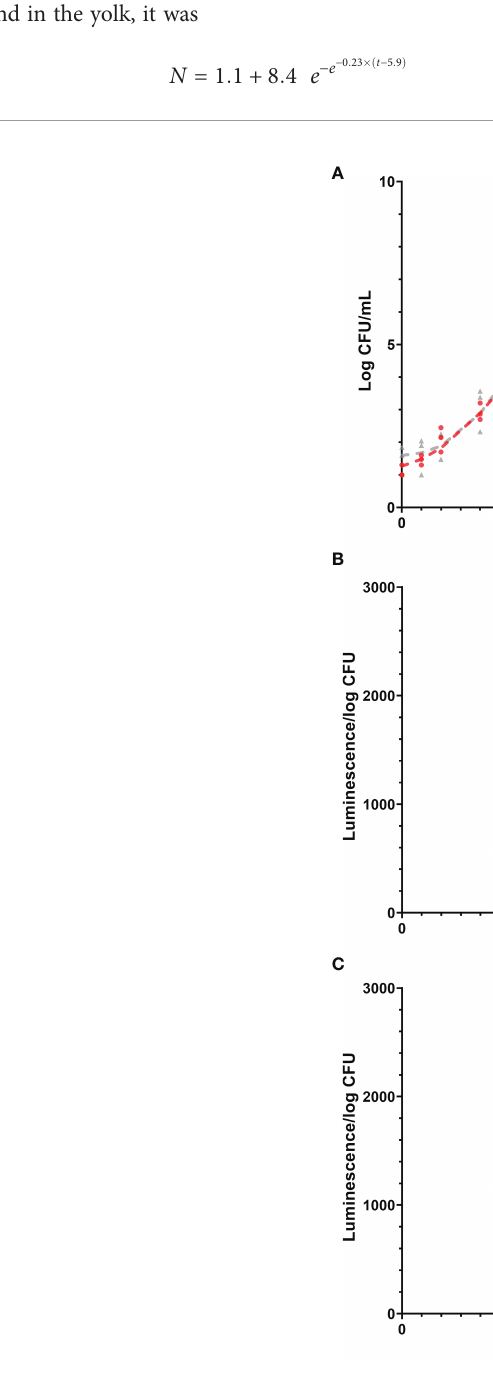
FIGURE 2 | Growth (log CFU/mL) of Salmonella Enteritidis and expression (luminescence units/log CFU) of promoters of virulence-related genes, sopB and sseA during growth of the corresponding Salmonella Enteritidis reporter strains, in tryptic soy broth (TSB) and egg yolk. Gray and red lines (and symbols) represent TSB and yolk, respectively. Log CFU/mL values are represented by symbols and growth curves, simulated by the mathematical model, are shown as dashed lines. Changes in luminescence/log CFU are represented by solid lines. (A) Growth curves of Salmonella Enteritidis in egg yolk and in TSB. (B) Expression of sopB . (C) Expression of sseA . Each error bar represents the standard deviation for the average of three independent replicates. Statistical signi fi cance: (**) p < 0.01; (****) p <